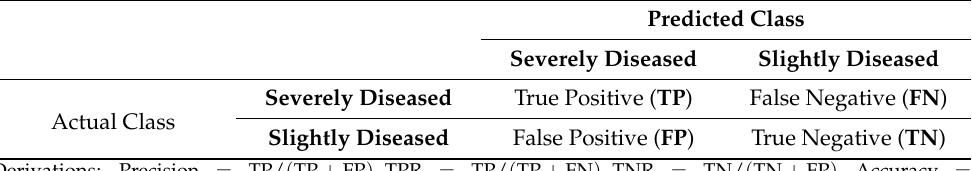
Table 1. The basic composition of the confusion matrix.